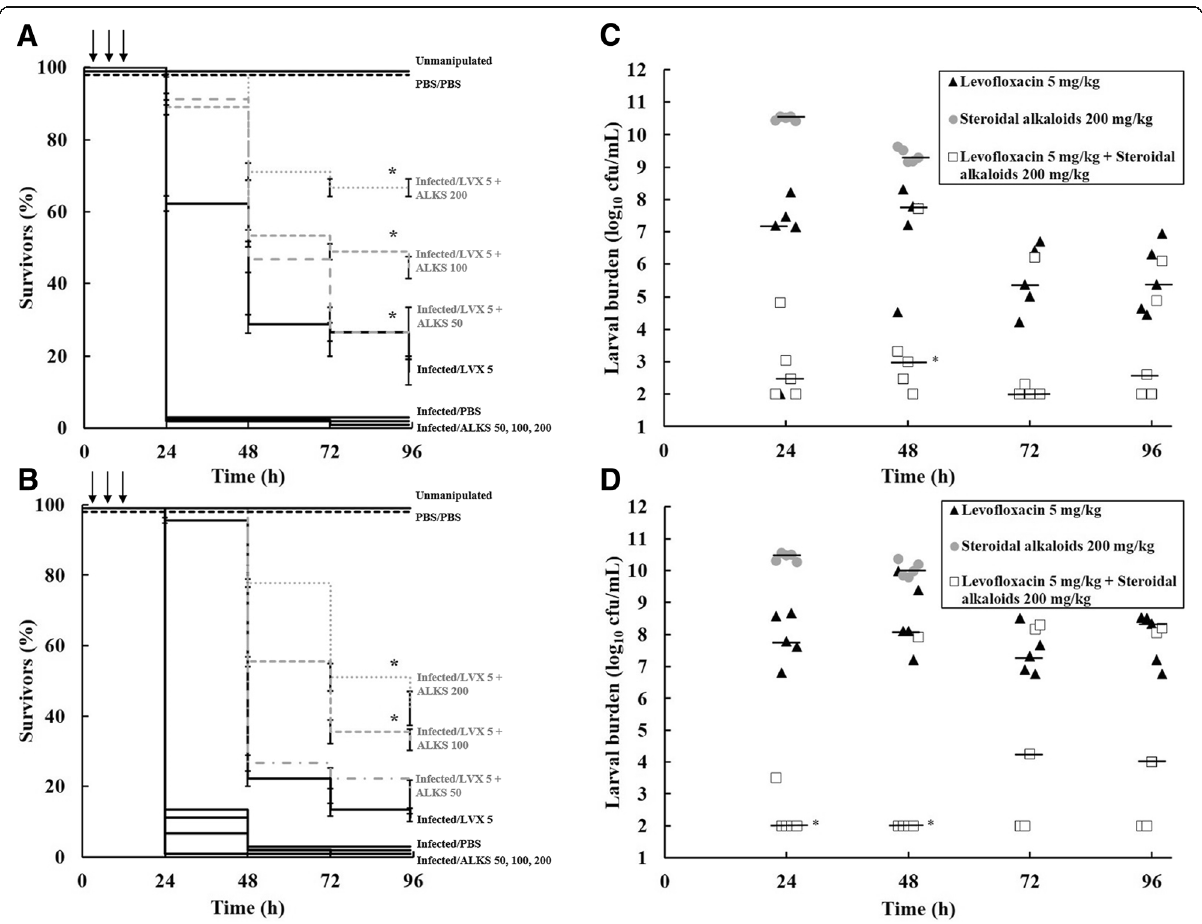
Fig. 1 Effect of treatment with combinations of steroidal alkaloids and levofloxacin on survival of G. mellonella larvae infected with P. aeruginosa PAM1032 ( a ) and PAM1034 ( b ), or larval burden of the same strains PAM1032 ( c ) and PAM1034 ( d ). All larvae were inoculated with 2.5×10 3 cfu/mL P. aeruginosa and treated with each agent individually or in combination with three doses at 2, 4 and 6 h post-infection (indicated by the arrows). Treatments consisted of PBS, steroidal alkaloids (50, 100 or 200 mg/kg), levofloxacin (5 mg/kg), and a combination of steroidal alkaloids with levofloxacin. Larvae were incubated at 37 °C for 96 h and survival recorded every 24 h. The burden of P. aeruginosa was determined from five individual larvae every 24 h. For clarity, data for treatment with PBS alone is not shown because the data obtained was similar to that obtained for steroidal alkaloid treatment alone. * a ) and b ); combination treatment group with significantly enhanced survival compared with any of the constituent monotherapies ( P <0.05, log-rank test with Holm ’ s correction for multiple comparisons). n =45 (pooled from triplicate experiments). Error bars indicate ±SEM. LVX, levofloxacin; ALKS, steroidal alkaloids. * c ) and d ); significant difference in larval burden between groups treated with the combination of steroidal alkaloids and levofloxacin compared with the constituent monotherapies; n =5 ( P <0.05, the Mann – Whitney U -test compared the combination therapy with each monotherapy individually). The black bar represents the median value of larval burden per